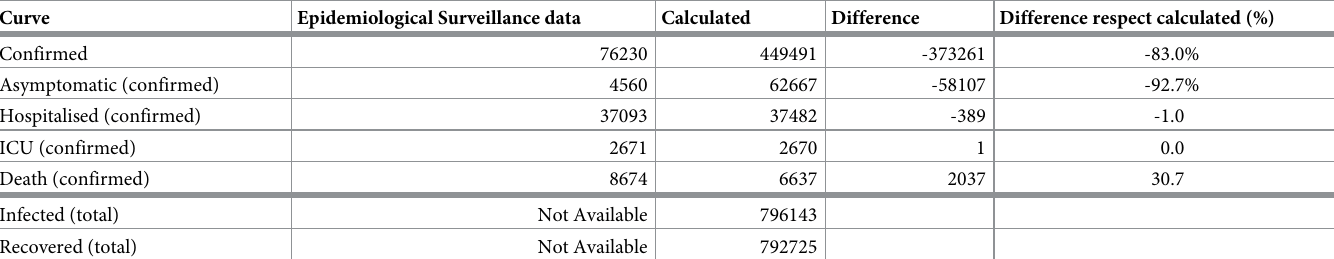
Table 4. Cumulative cases at the end of the first wave (28 th June 2020). Curve